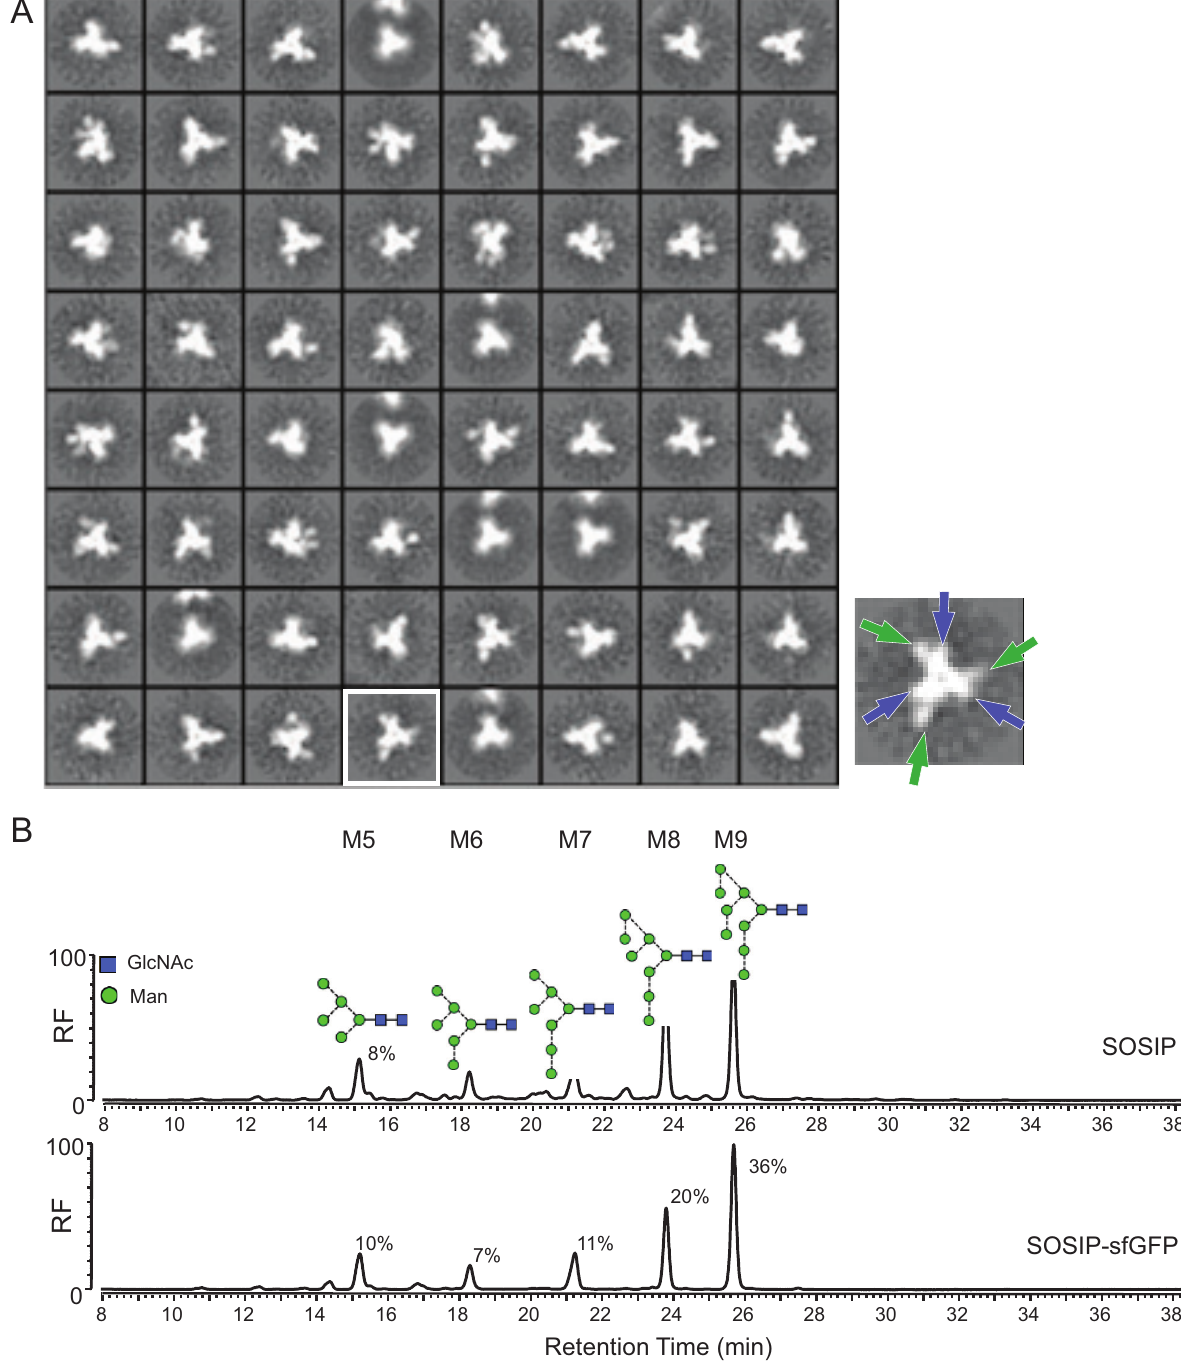
Figure 3. Conformation and glycosylation of SOSIP-sfGFP. ( A ) Negative stain electron microscopy (NS-EM) 2D class averages of PGT145-purified SOSIP-sfGFP. The three propeller blades of the Env trimer (blue arrows) and the protruding densities (green arrows) are highlighted in the image on the right; ( B ) HILIC-UPLC spectra of N -linked glycans derived from SOSIP or SOSIP-sfGFP. Peaks corresponding to oligomannose glycans (Man 5-9 GlcNac 2 ) are labeled M5-M9. The relative abundance of M5-M9 is given. The smaller peaks that are not highlighted correspond to complex or hybrid-type